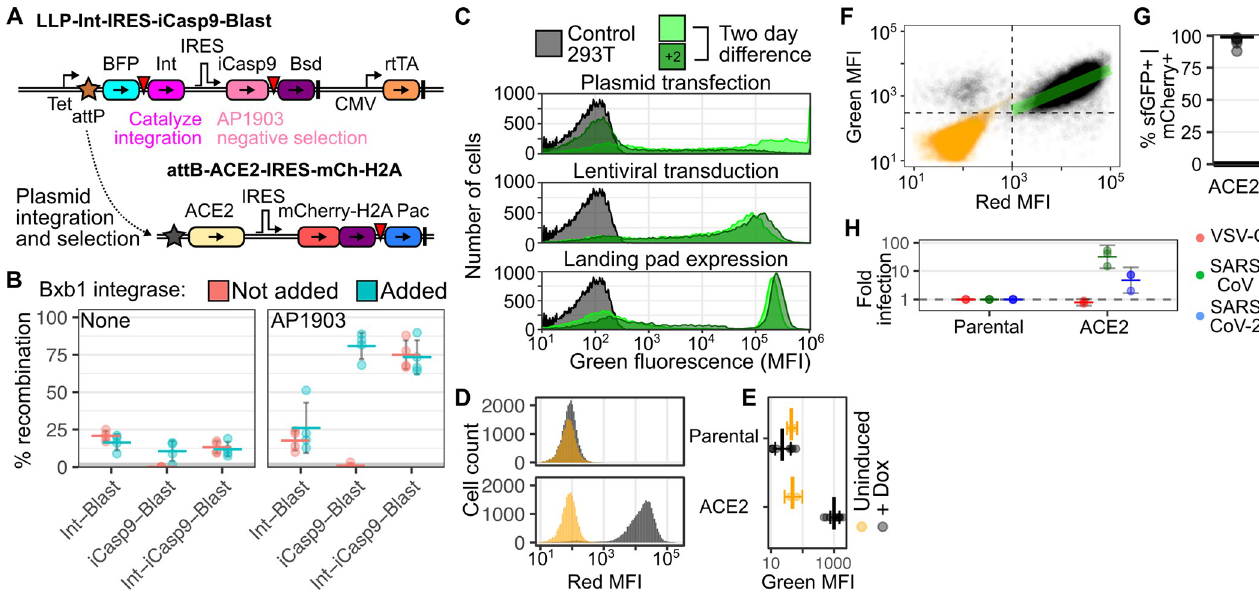
Fig 1. Improved cell engineering platform expressing human ACE2. A) Schematic of the newly described LLP-Int-iCasp9-Blast landing pad (top), and the ACE2 expression construct used in the majority of this study (bottom). Key: Tet, Tet-inducible promoter; BFP, Blue fluorescent protein; Int, Bxb1 integrase; IRES, Internal Ribosome Entry Site; iCasp9, inducible caspase 9; Bsd, Blasticidin-S deaminase; CMV, Cytomegalovirus promoter; rtTA, reverse tet transactivator; H2A, Histone 2A; Pac, Puromycin N-acetyltransferase; attP and attB are Bxb1 recombination sites. Inverted red triangles denote viral 2A-like sequences allowing co-translational separation of the polyprotein. Thick vertical lines are transcriptional terminator sequences. B) Percentages of recombined cells in various HEK 293T Bxb1 landing pad cells, in the absence (left) or presence (right) of negative selection agent AP1903. Red and blue indicate the absence and presence of exogenous Bxb1 integrase expression plasmid, respectively. n = 4; error bars denote 95% confidence intervals. C) Representative smoothed histograms of the flow cytometry mean fluorescence intensities of cells where GFP was expressed by plasmid transfection (top), lentiviral transduction (middle), or recombination into the landing pad (bottom). Light and dark green correspond to days 3 and 5 after plasmid transfection, respectively. For the lentivirus transduced and Bxb1 recombined cells, the cells had been generated a week before the first time-point. D) Representative mCherry fluorescence distribution of ACE2-recombined cells, as captured by flow cytometry, in cells left uninduced (orange) or induced to express ACE2 from the Tet-inducible promoter using 2 μ M doxycycline (black). E) Geometric means of green fluorescence of SARS-CoV-2 RBD-sfGFP -stained ACE2 expressing cells. n = 2 and 8 for uninduced and induced cells, respectively. Error bars denote 95% confidence intervals. F) Representative scatterplot of mCherry fluorescence and RBD- sfGFP staining of ACE2 recombinant cells. The green line denotes the linear correlation between red and green MFI for the double-positive population. Pearson’s r 2 = 0.44. G) Percent of mCherry positive cells that were also positive for SARS-CoV-2 RBD-sfGFP staining, for 5 repeat staining experiments. H) Fold pseudovirus infection of ACE2 overexpressing cells, normalized to infection of parental HEK 293T cells. n = 3 for SARS-CoV and SARS-CoV-2 spikes, error bars denote 95% confidence